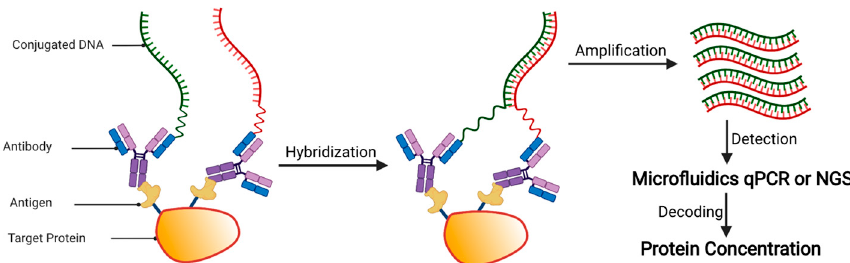
Figure 4. Schematic overview of proximity extension assay (PEA) analysis. Upon sample incubation, the antibody-based proximity probe pair binds to its specific antigens on the same protein. As a result, the pair of probes come in close proximity and hybridize. The addition of a DNA polymerase causes the hybridizing oligo to be extended, resulting in a DNA template that can be detected and quantified by quantitative PCR (qPCR) or next-generation sequencing (NGS).